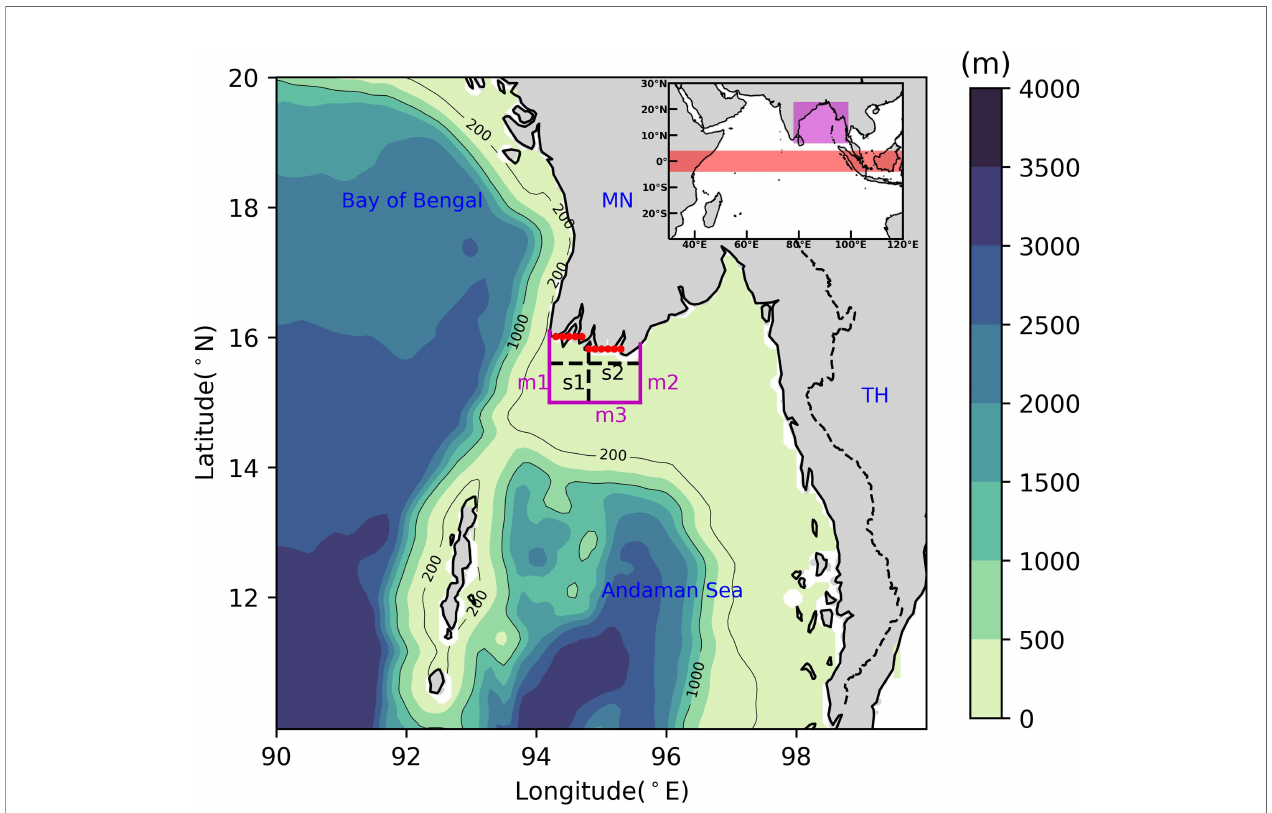
FIGURE 2 | Study area for IR plume. Shading represents bathymetry in meters. Solid magenta lines represent sections m1, m2 and m3 along 94.2°E, 95.6°E and 15.0°N respectively. Thick dashed black lines represent sections s1 and s2 along 94.8°E and 15.6°N respectively. Thin black lines represent isobaths of 200m and 1000m. Red dots represent the positions of source points at which the river runoff is speci fi ed in the model. Inset shows model domain encompassing entire Indian Ocean (30°E – 120°E and 30°S – 30°N). Area marked by red color in the inset is the equatorial region over which the wind forcing was applied in experiment IREqW and area marked by magenta is the area (encompassing the entire Bay of Bengal) over which the wind forcing was applied in experiment IRBoBW 1. Thin dashed black line represents international border between Myanmar and Thailand. Countries Myanmar and Thailand are shown by words ‘ MN ’ and ‘ TH ’